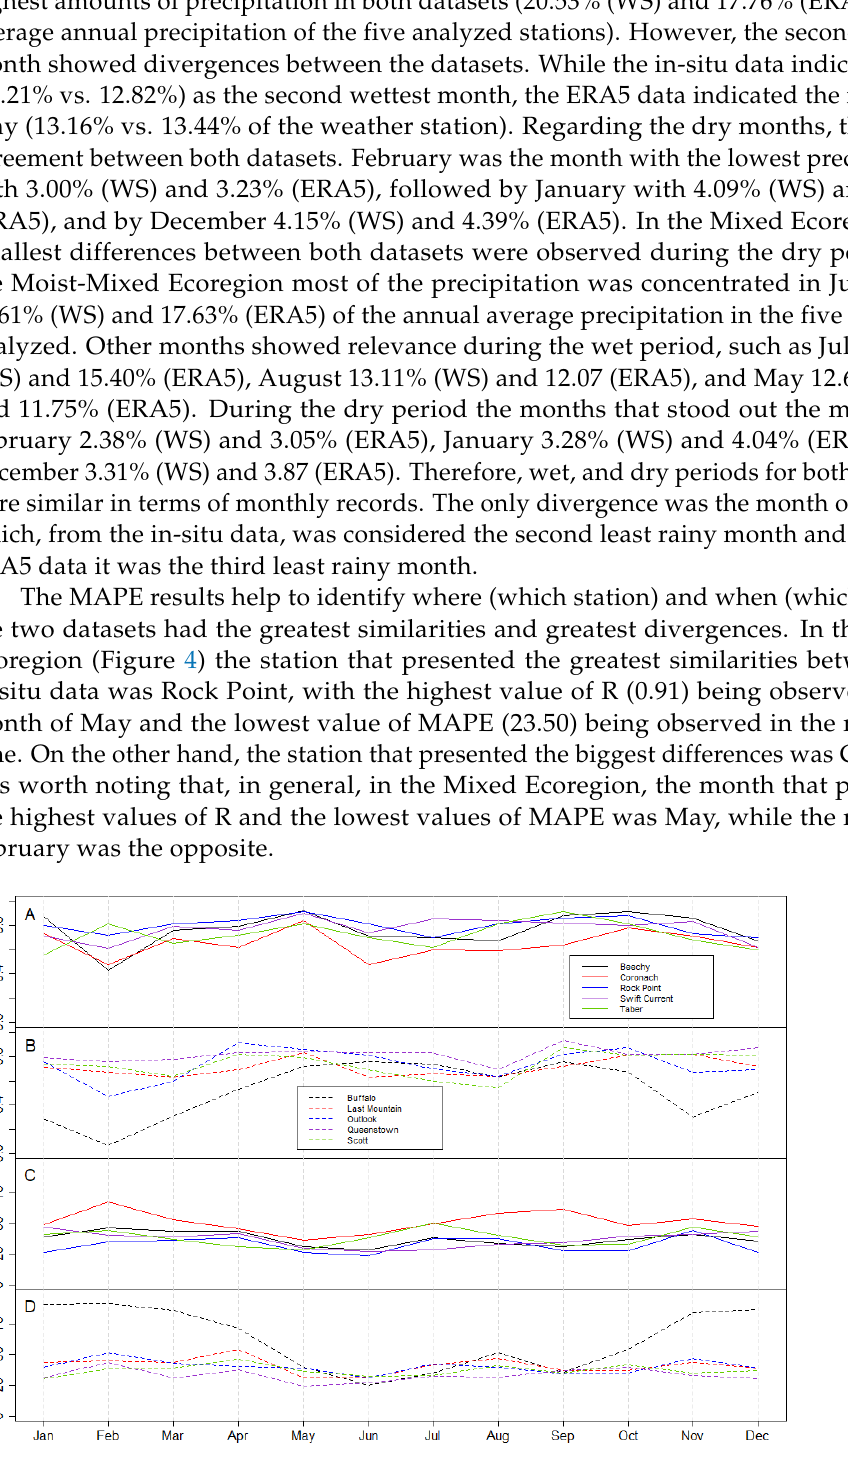
Figure 4. Monthly correlation coefficients and MAPE results for stations located in the Mixed Ecore- gion and in the Moist-Mixed Ecoregion. Graphs ( A ) and ( B ) indicate, respectively, the monthly R values between measurements made by weather stations and ERA5 estimates in the Mixed Ecore- gion and the Moist-Mixed Ecoregion. Graphs ( C ) and ( D ) indicate, respectively, the monthly MAPE values between measurements made by weather stations and ERA5 estimates in the Mixed Ecore- gion and the Moist-Mixed Ecoregion.